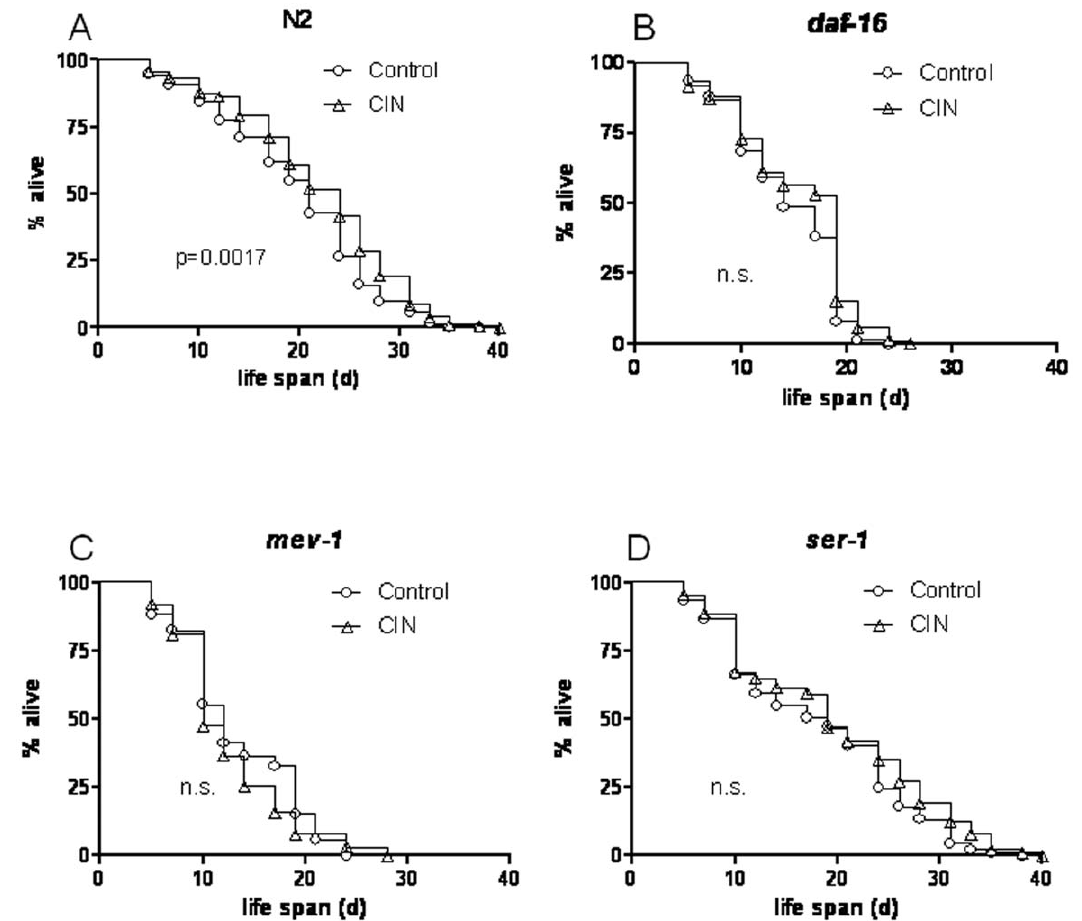
Figure 1. Effect of Cinnamomumcassia (CIN) on life span in multiple pathway mutants of C.elegans . Age synchronized control (circles) or CIN fed (triangles) worms were seeded in liquid medium at the L1 stage. CIN treatment began 68 h after seeding (day 1 of adult life) and the fraction of animals alive was scored microscopically on the basis of movement. A. CIN significantly extends life span in wild type worms but not in B. daf-16 C. mev-1 or D. ser-1 mutants. Survival rate was scored every day and is expressed as percentage of survival. The experiment was conducted at least three times with a minimum of 100 worms per trial. Statistical significant p , 0.05, n.s. not significant.